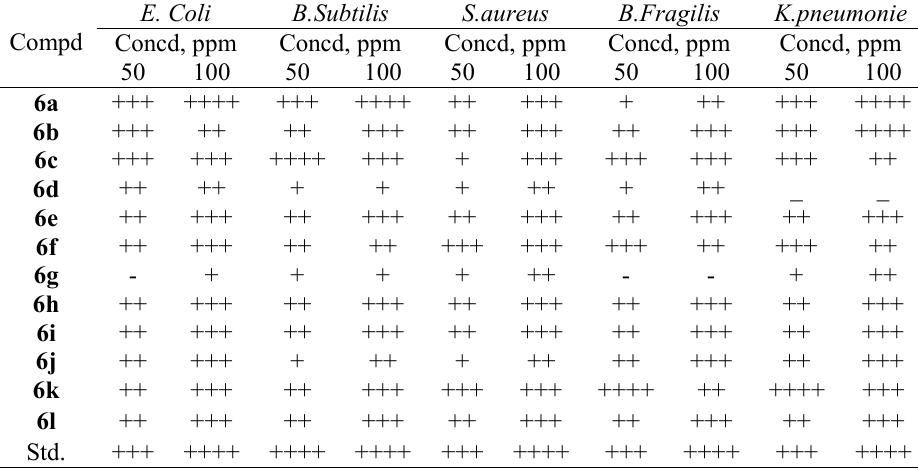
Std. streptomycin is used as standard drug. Inhibition diameter in mm:- 0-4(-), 5-9(+),10-14(++),